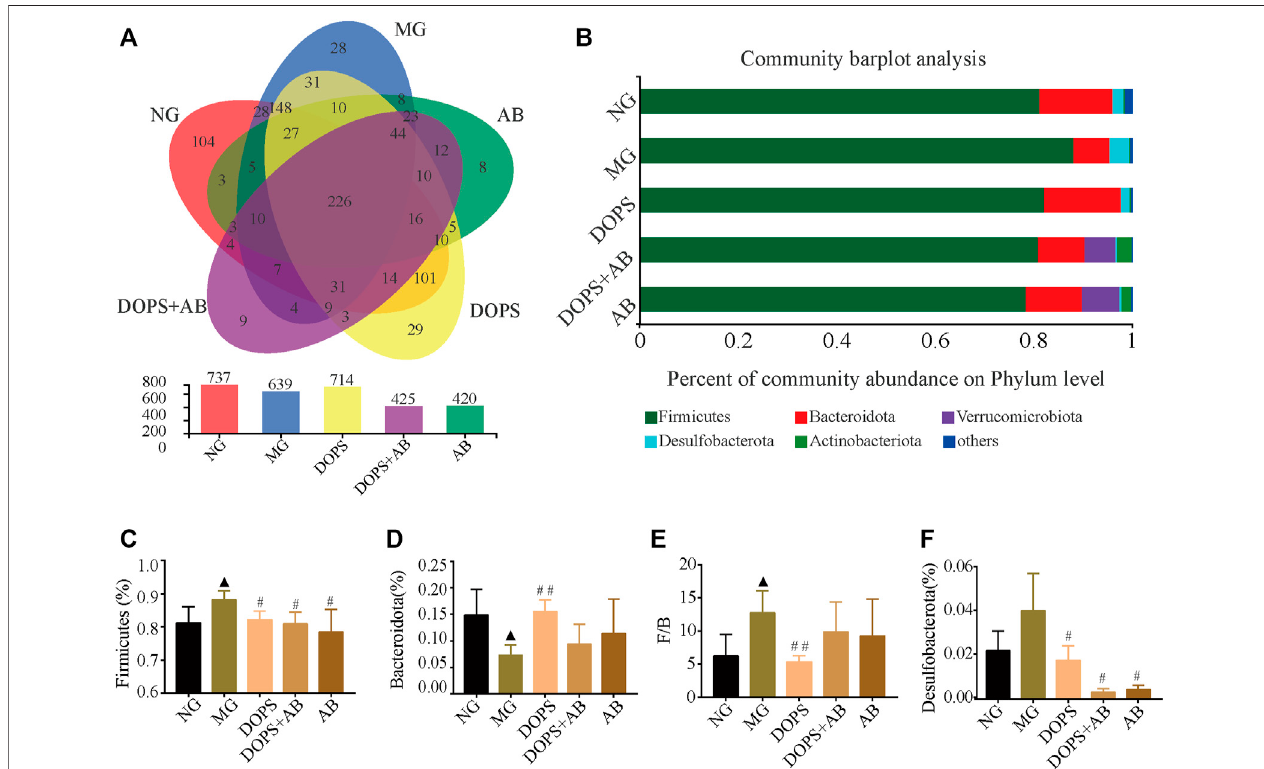
FIGURE 7 | Effect of DOPS on the abundance and phylum level of intestinal fl ora in the MH rats. (A) Venn plot analysis of species on phylum level. (B) Percent of community abundance on phylum level. (C – F) Firmicutes, Bacteroidetes, and Desulfobacterota abundance ratio and Firmicutes/Bacteroidetes (F/B) statistical analysis. NG,normalcontrolgroup;MG,modelcontrolgroup;DOPS, Dendrobiumof fi cinale polysaccharide;DOPS+AB, Dendrobiumof fi cinale polysaccharide+antibiotics;AB, antibiotics. Compared with the normal control group, ▲ p < 0.05 and ▲▲ p < 0.01; compared with the model control group, # p < 0.05 and ## p < 0.01 ( n = 3 –